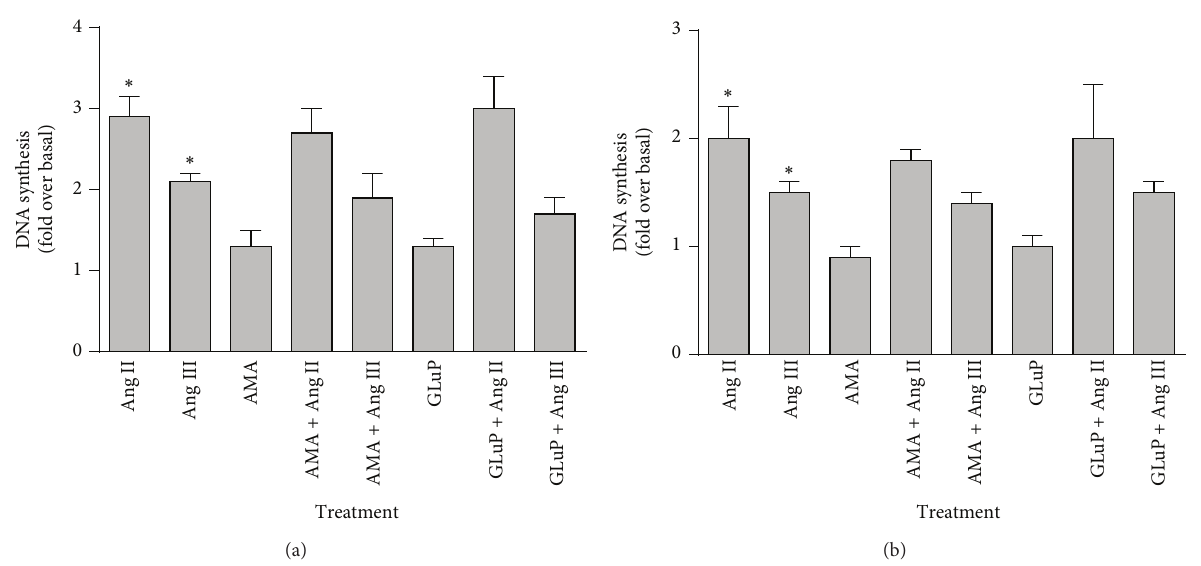
Figure 3: Effect of AMA and GluP on Ang II- and Ang III-induced DNA synthesis. Quiescent monolayers of brainstem (a) and cerebellum (b) astrocytes were incubated for 48 hours with 100 nM Ang II or Ang III in the presence and absence of 10 𝜇 M AMA or 100 𝜇 M GluP. During the last 24 hours of treatment, 3 H-Thymidine was added and DNA synthesis measured as described. Cells were also treated with the inhibitors alone. Each value represents the mean ± SEM of preparations of brainstem and cerebellum astrocytes from 6 or more litters of neonatal rat pups. ∗ denotes that 𝑃 < 0.05 as compared to basal levels of DNA